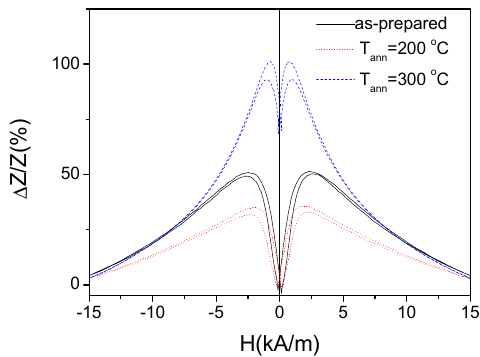
Figure 6. Δ Z/Z ( H ) dependencies of as-prepared and annealed Fe 3.6 Co 69.2 Ni 1 B 12.5 Si 11 Mo 1.5 C 1.2 microwires measured at 500 MHz.